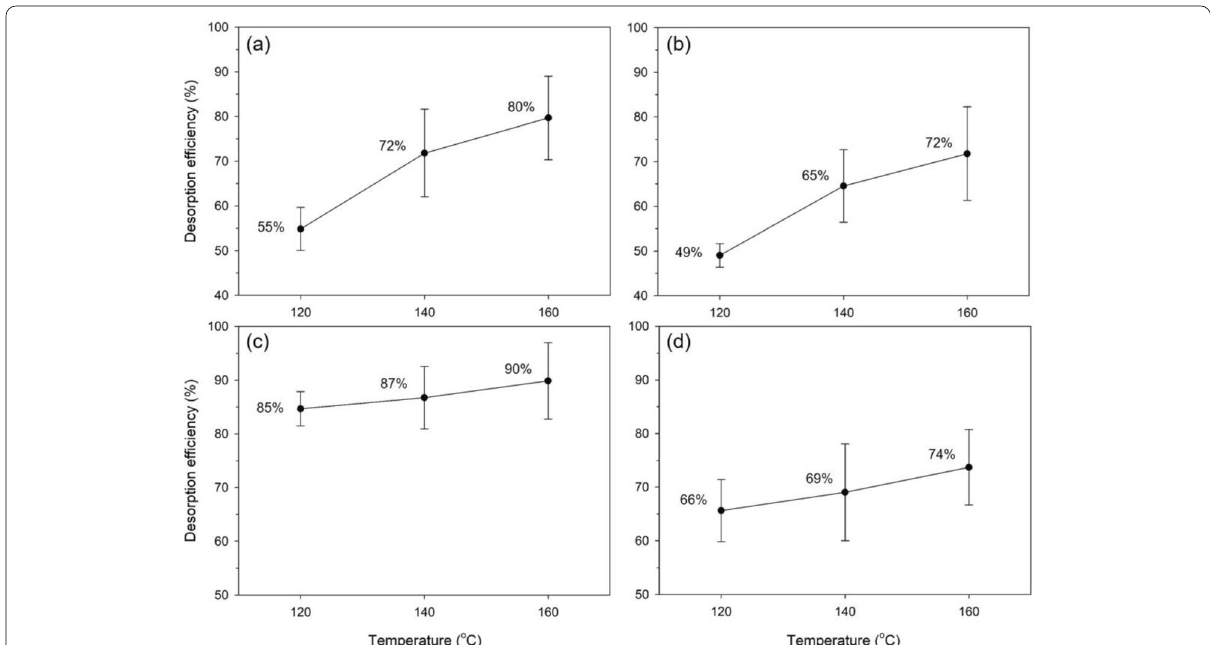
Fig. 9 Desorption efficiencies for a TOL‑KBAC by gravimetric method, b TOL‑KBAC by integral method, c MEK‑KBAC by gravimetric method, and d MEK‑KBAC by integral method (n =